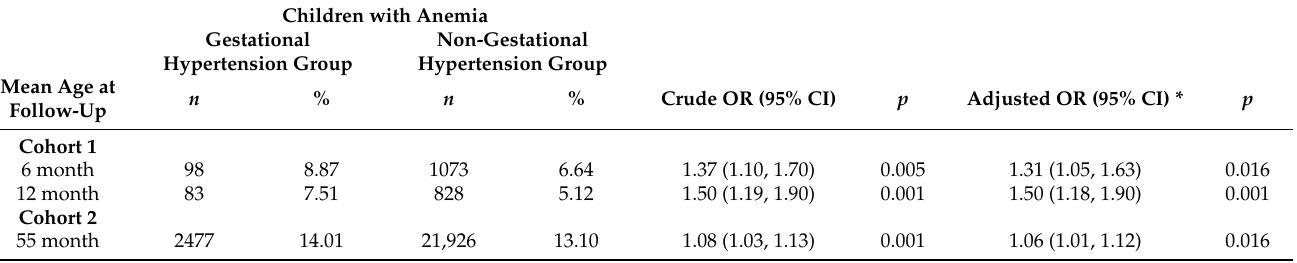
Table 2. Crude and adjusted RRs of anemia for gestational hypertension group compared with non-gestational group.